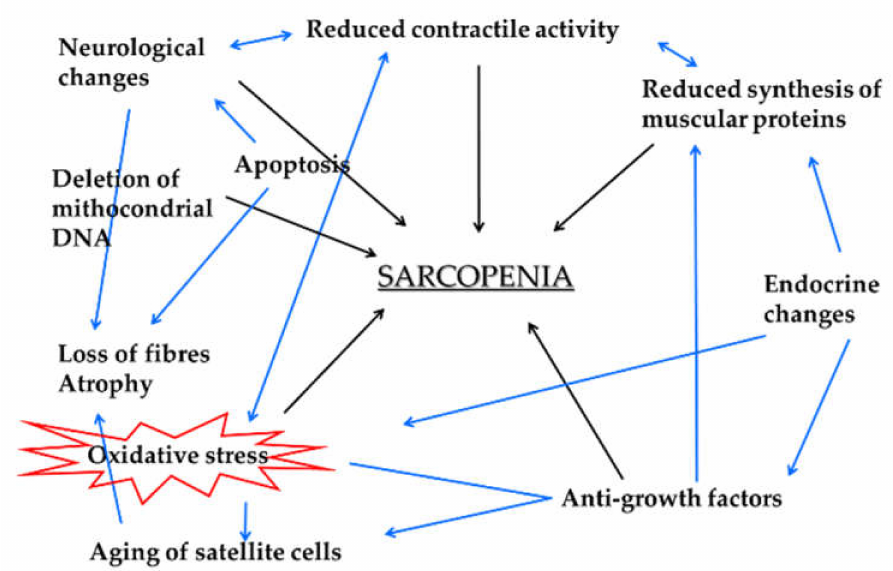
Figure 1. The role of oxidative stress in sarcopenia. Skeletal muscle aging is a complex process that is associated with a decrease in mass, strength and velocity of contraction, known as sarcopenia. This process is the result of many cellular changes. Notably, sarcopenia is triggered by reactive oxygen species (ROS), resulting in oxidative stress that can damage DNA, proteins, lipids, etc., causing further damage to the cells and tissues. Black arrows represent direct correlations with sarcopenia, while blue arrows represent indirect